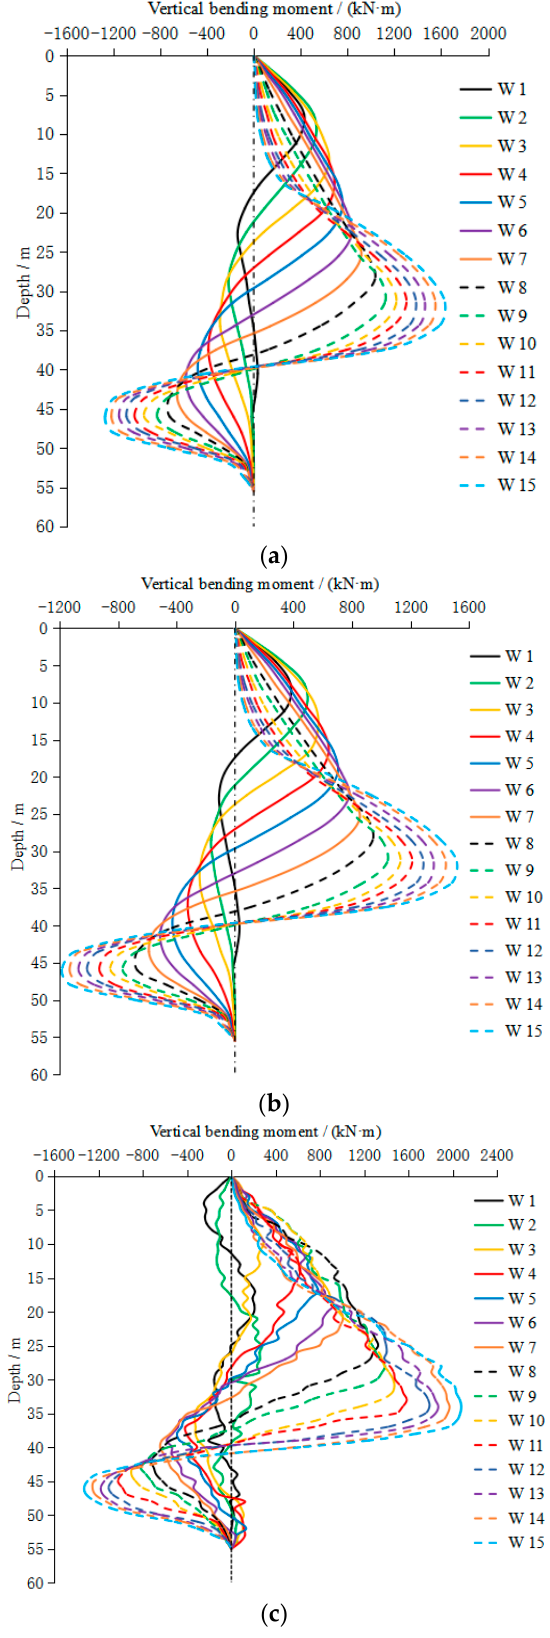
different working conditions. ( d ) Variation of maximum circumferential stresses with excavation depth.